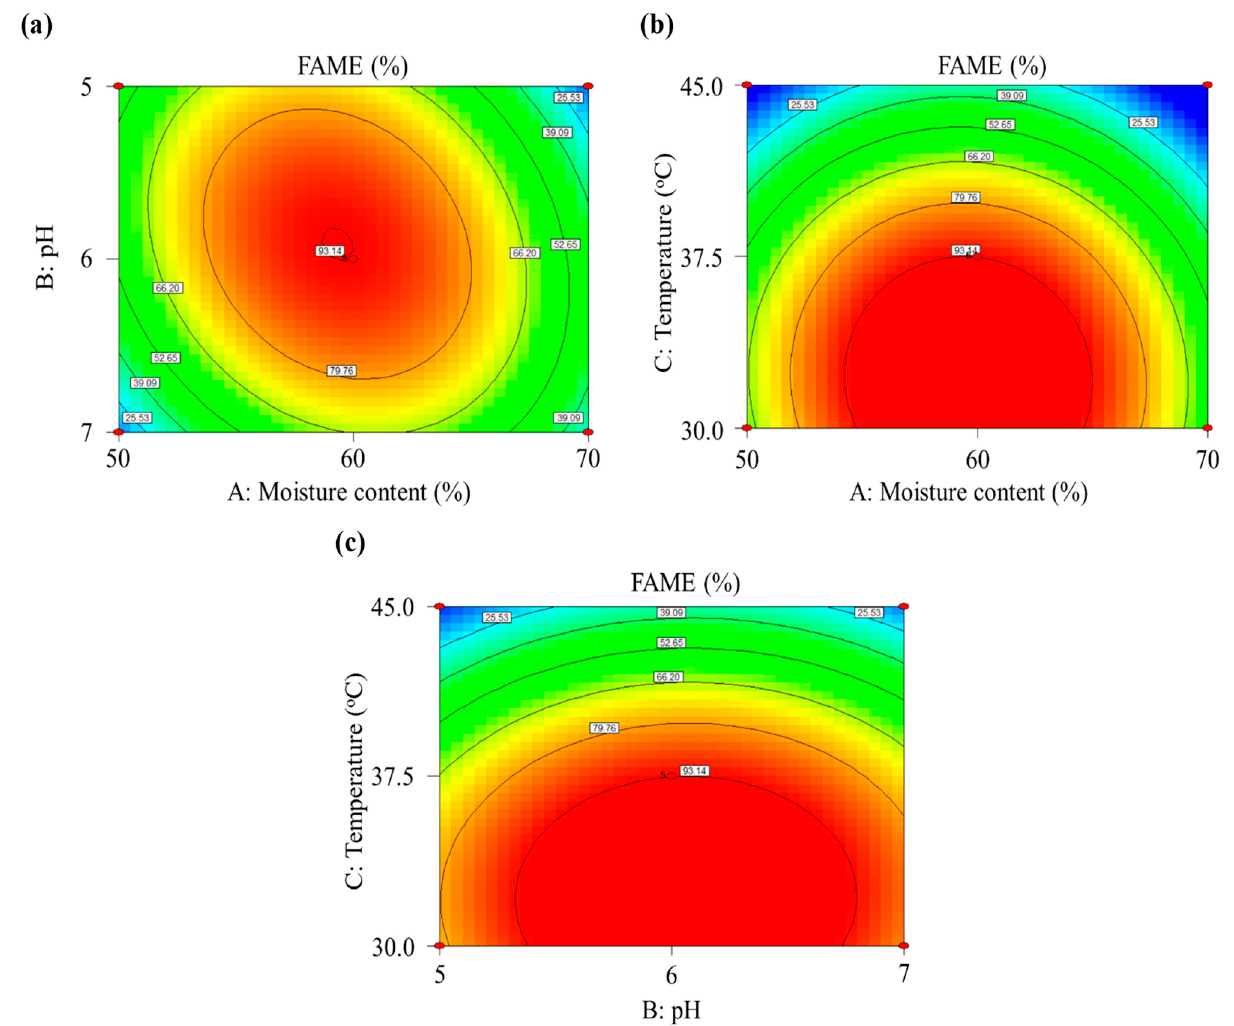
Figure 3. Two-dimensional contour plots showing the effect of ( A ): moisture content (%), ( B ): pH and ( C ): temperature (°C) on fatty acid methyl esters (FAME; %) synthesized by transesterification. One variable kept constant at its center point and other two variables varied within the experimental range. As shown in ( a – c ).